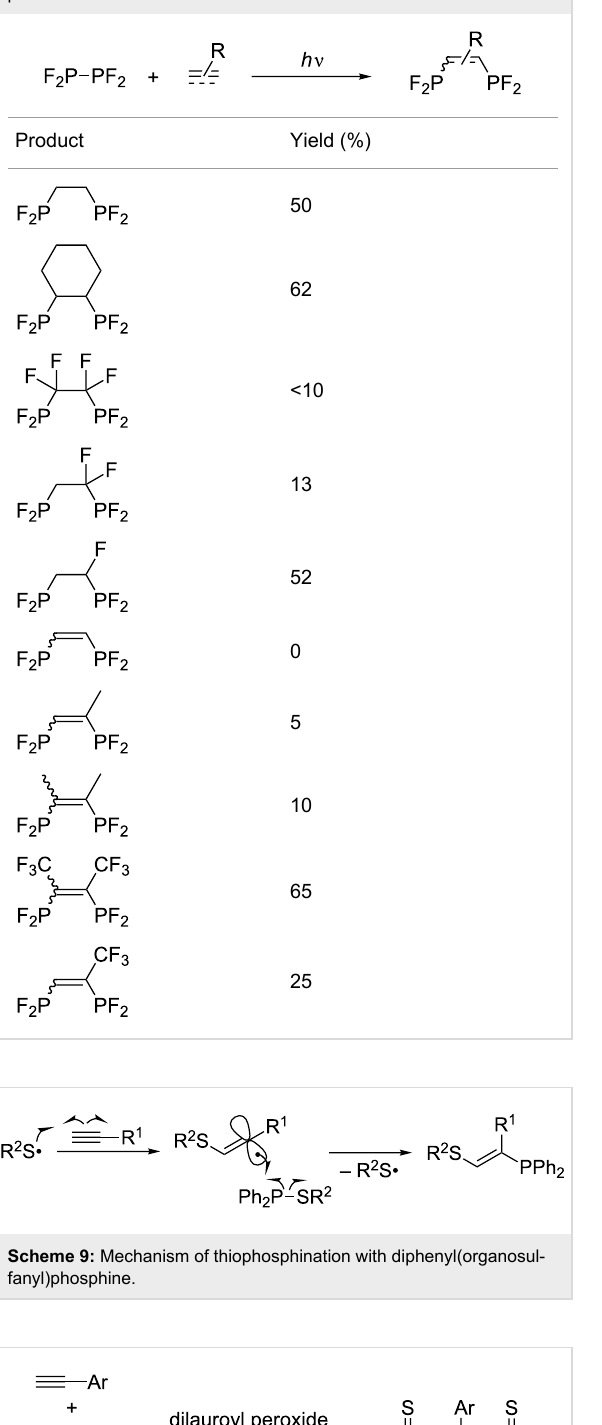
Table 3: Photoinduced radical diphosphination with tetrafluorodiphos- phine.